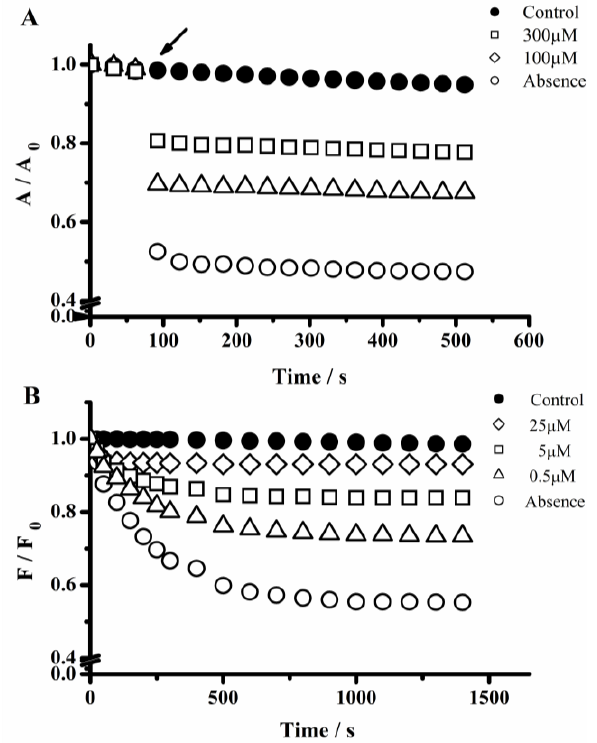
Figure 5. Effect of ferulic acid on the consumption of PGR or PYR induced by hypochlorite. ( A ) Kinetic profiles of the reaction between PGR (15 µM) and hypochlorite (10 µM) in the absence and presence of ferulic acid at 100 and 300 µM. The arrow indicates the time at which hypochlorite was added. ( B ) Kinetic profiles of the reaction between PYR (5 µM) and hypochlorite (10 µM) in the absence and presence of ferulic acid at 0.5; 5 and 25 µM. Controls experiments (PGR or PYR plus ferulic acid in the absence of